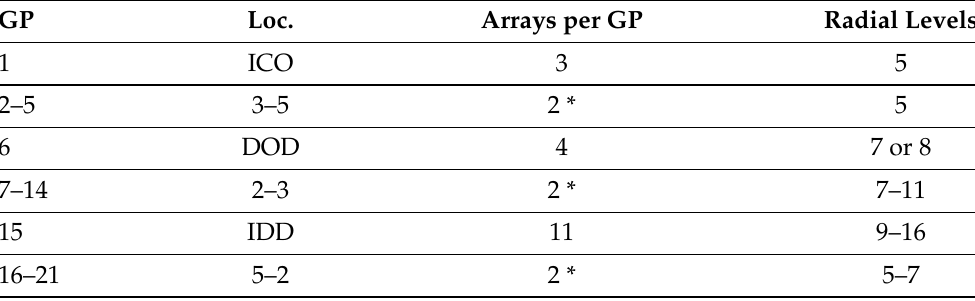
Table 2. Minimum Radial Constraints Implied by Gauge Points. Gauge points imply a fairly restrictive set of radial and angular locations. Gauge points not located on the icosahedral symmetry axes can only be met by two point arrays (*), referred to as sister arrays and are identical at all but one radial level; see Figure 4. This restriction is the minimal set, as point arrays can be combined to form larger arrays, though no points may be removed; see [3]. Loc. Arrays per